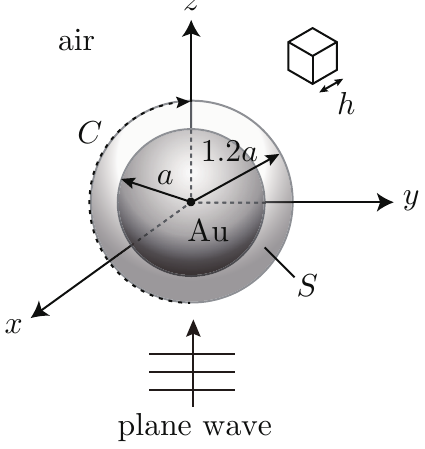
Figure 6. Simulation setup for a Au sphere ( a = radius, h = grid spacing). Incident E polarized wave propagates along the z axis. Au sphere (gray region) is immersed in air (white region). FDTD results are compared with Mie theory on surface S of radius 1 : 2 a and contour C on S in the y - z plane (dotted